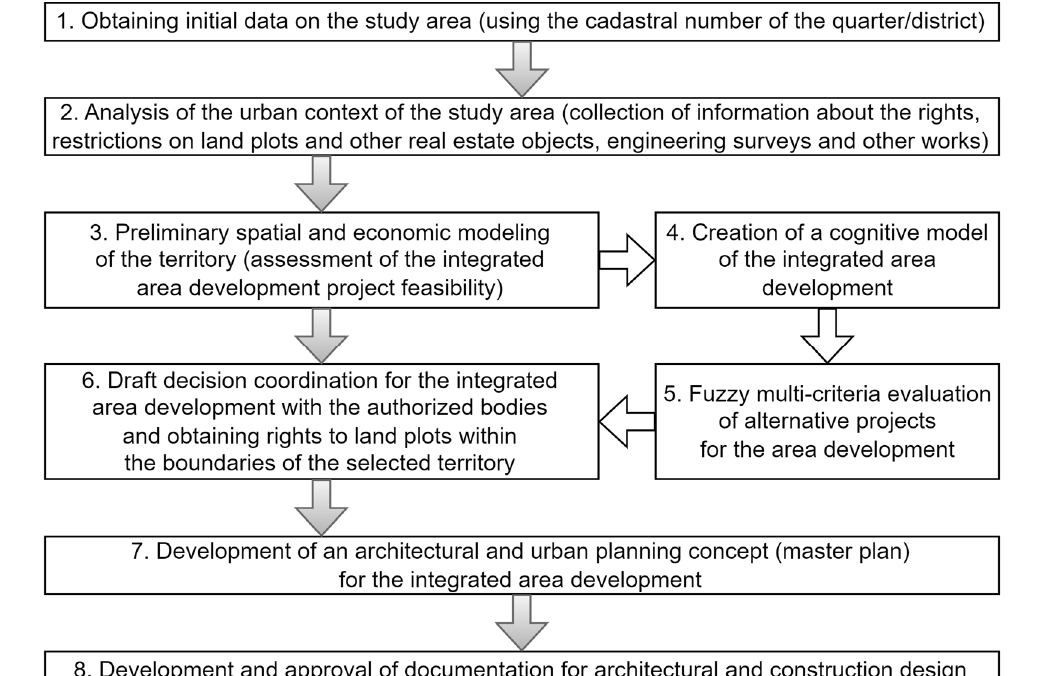
Table 1. Types and sources of